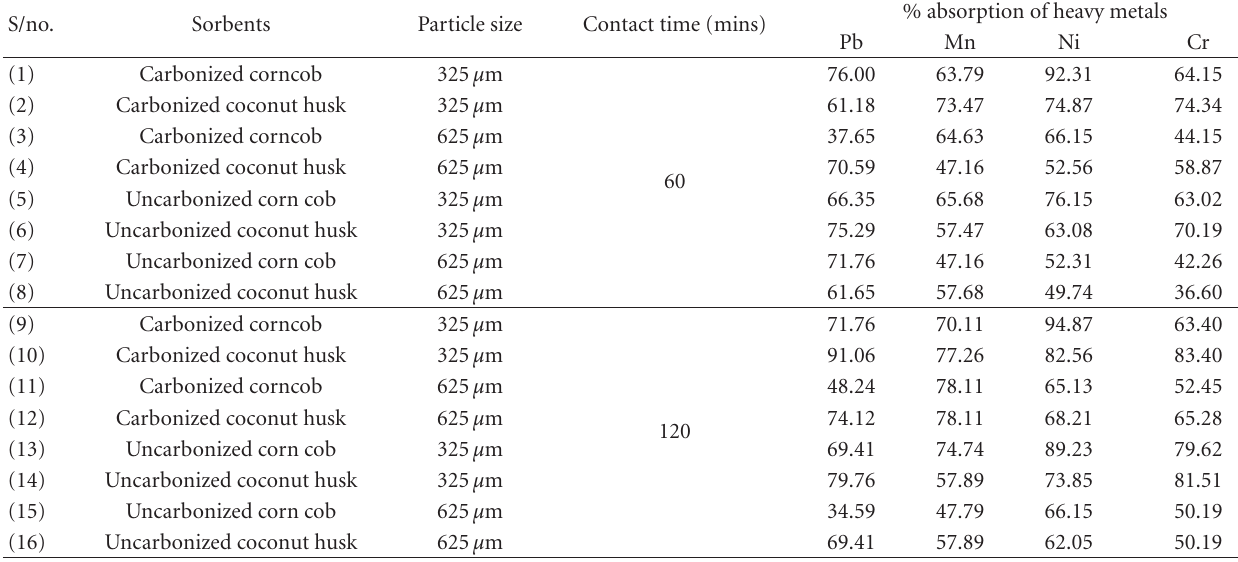
Table 4: Use of carbonized/uncarbonized waste cellulosic sorbents in removal of heavy metals from wastewater.